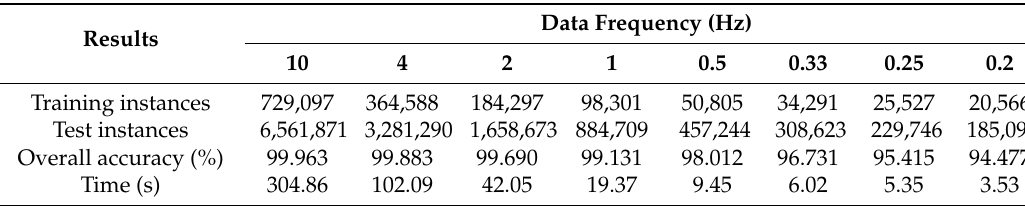
Table 7. Summary of classification